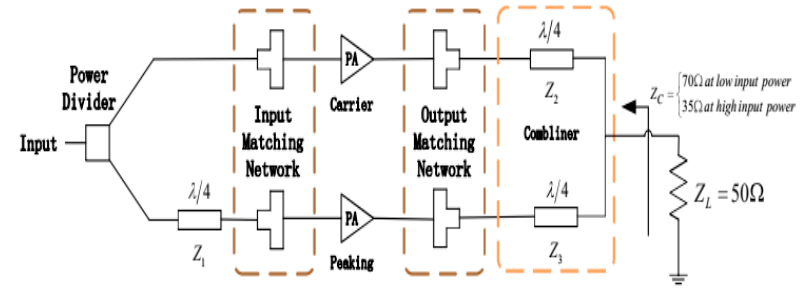
Figure 13. Load modulation proposed by [52].